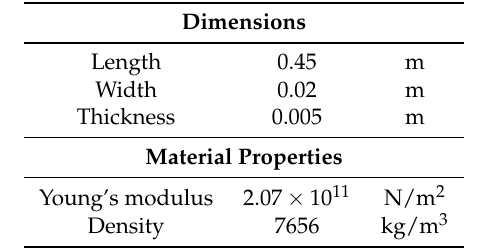
Table 1. Details of the cantilever beam.